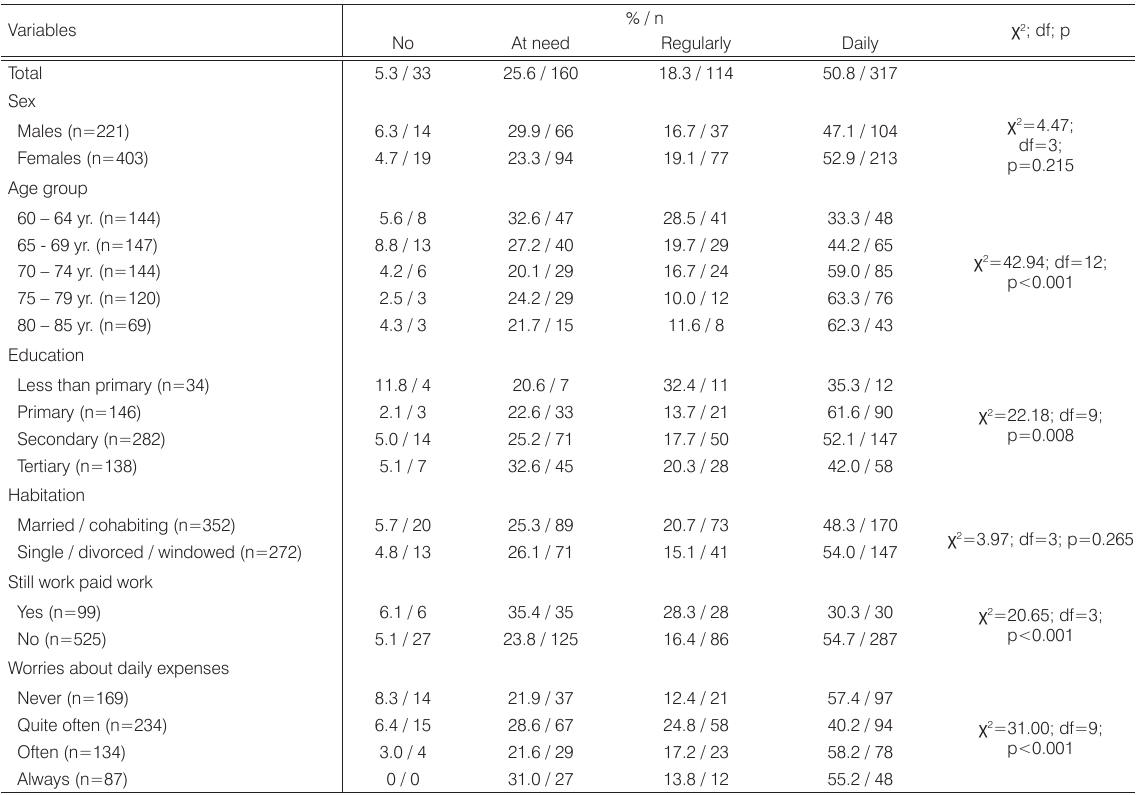
Table 1. Prevalence of medication use in different socio-economic